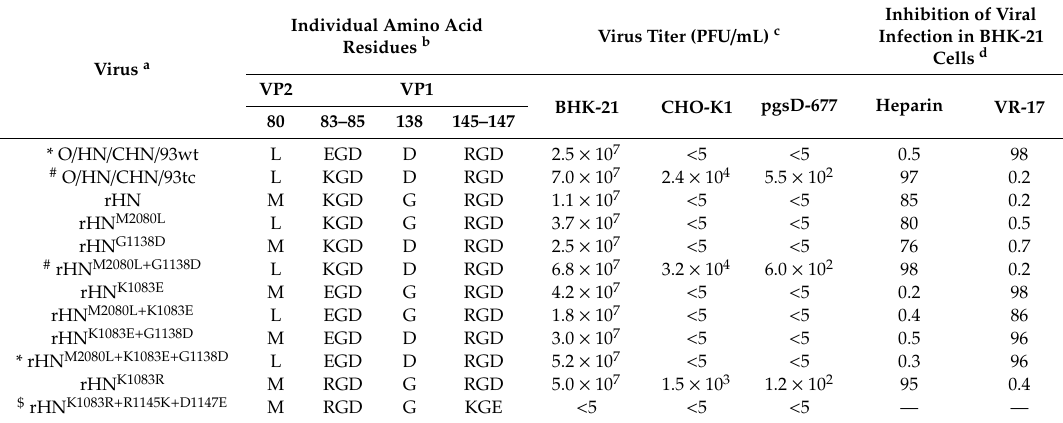
Table 2. The phenotypic properties of distinct genetic and engineered foot-and-mouth disease viruses (FMDVs) in BHK-21 and two CHO cell lines.